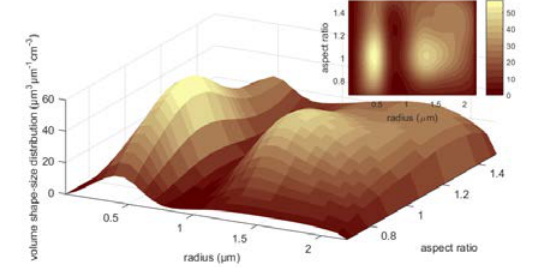
Figure 3. Retrieved shape-size distribution shown in 3D and in ar-plane for 1.5-2.75 km.